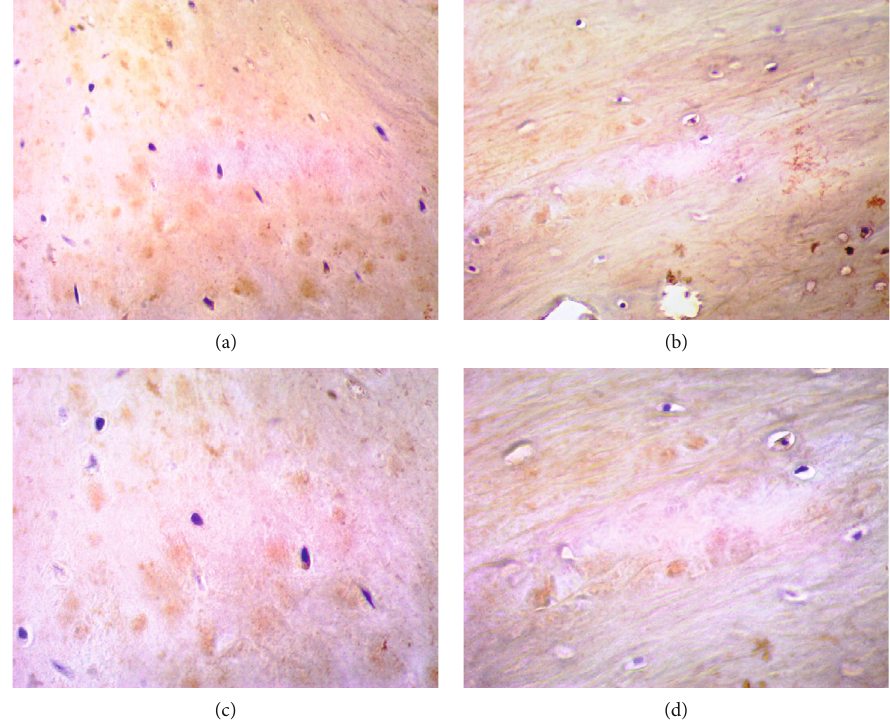
Figure 3: The representative microphotographs showing CX3CR1 expression in examined articular cartilage slices. (a) Articular cartilage from hemophilic arthropathy patient ( × 200 magni fi cation). (b) Articular cartilage from osteoarthritis patient ( × 200 magni fi cation). (c) Articular cartilage from hemophilic arthropathy patient ( × 400 magni fi cation). (d) Articular cartilage osteoarthritis patient ( × 400 magni fi cation).